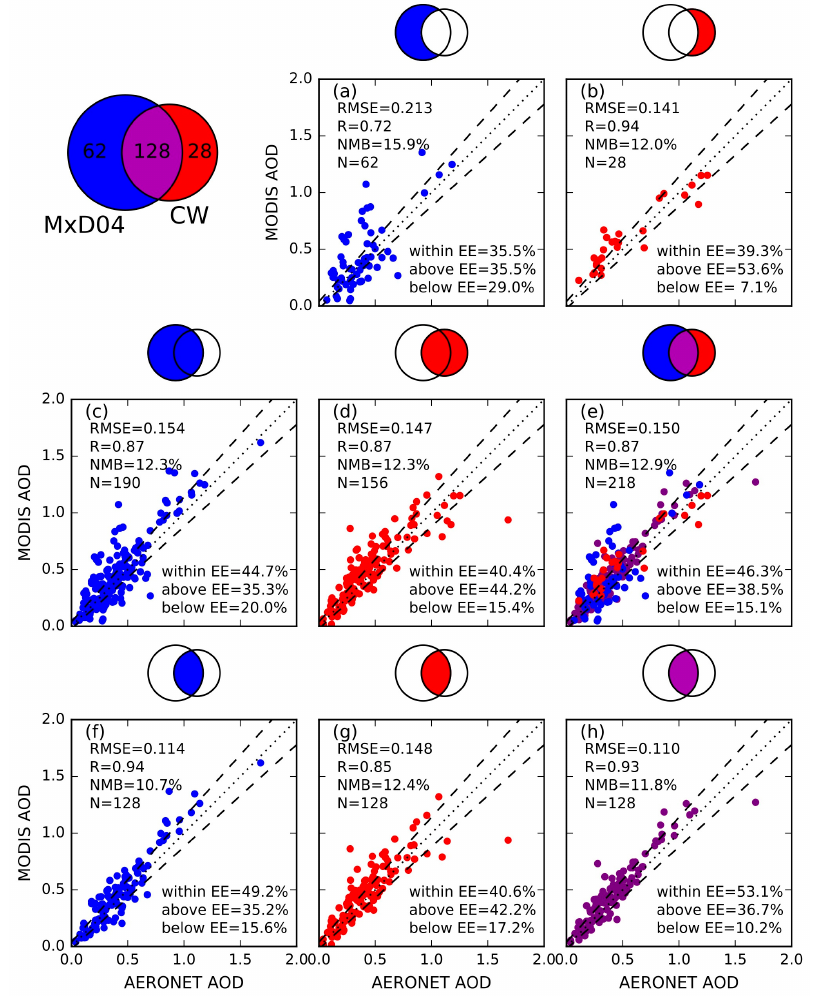
Figure 6. Scatter plots of 0.55 μ m AOD retrievals from MODIS (MxD04 and/or CW) versus AERONET observations of 6 sites in one month. Venn diagram on the upper left represents number of collocated data sets for MxD04-AERONET (blue), CW-AERONET (red), (MxD04 + CW)-AERONET (purple). Color part of Venn diagram on the top of each scatter plot ( a-h ) represents which collocated data sets are plotted; see details in the text for further description of the Venn diagram. ( a ) is MxD04-AERONET in the situation that only MxD04 retrievals are available within the 25-km of AERONET site. ( b ) is CW-AERONET in the situation that only CW retrievals are available. ( c ) and ( d ) are similar to ( a ) and ( b ), respectively, but both additionally include AOD retrievals from their respective counterparts of the situation that both MxD04 and CW retrievals are available. ( e ) is (MxD04 + CW)-AERONET in all the three situations. ( f ), ( g ), and ( h ) are MxD04-AERONET, CW-AERONET, (MxD04 + CW)-AERONET, respectively, in the situation that both MxD04 and CW retrievals are available. 1:1 lines and expected error (EE) envelopes (+(0.04 + 10%), − (0.02 + 10%), asymmetric) are plotted as dot and dashed lines. The number of collocated pairs (N), root mean square error (RMSE), normalized mean bias (NMB), and linear correlation coefficients are also shown.